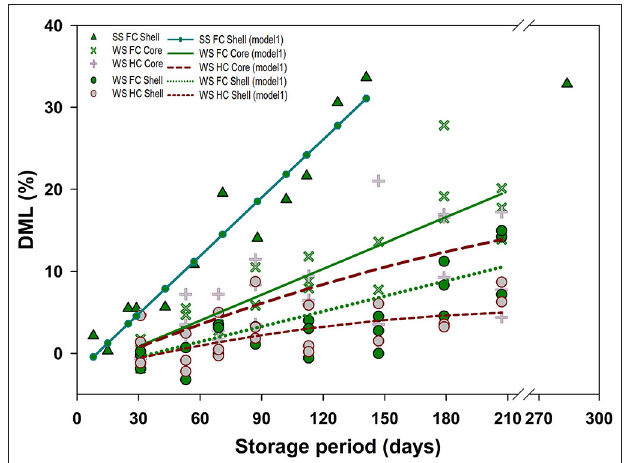
FIGURE 4 | Representation of predicted dry matter loss (DML) (model 1) and DML value for fresh (FC) and hot water extracted (HC) willow biomass chips that were stored at various initial moisture in outdoor piles created in the winter (WS) and summer